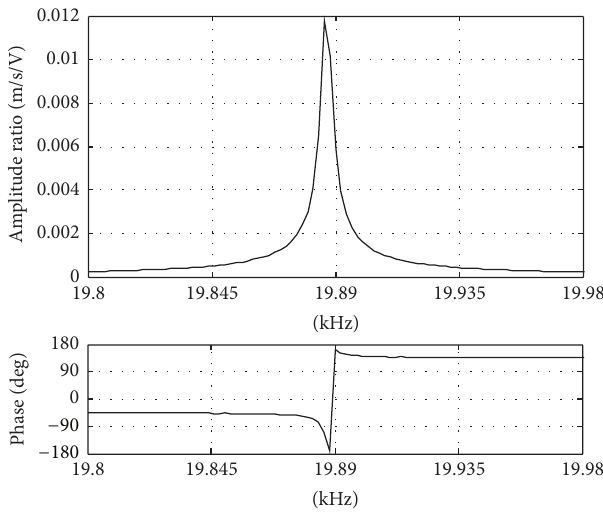
Figure 3: Experimental frequency response